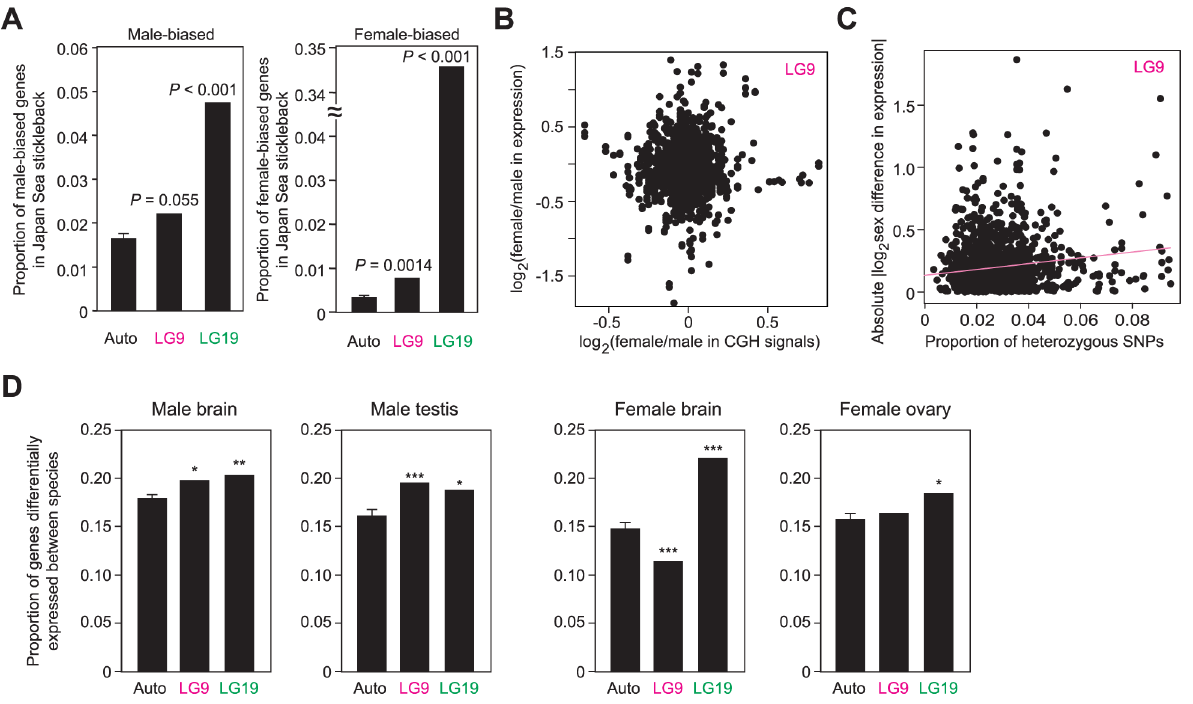
Figure 6. Contribution of neo-sex chromosomes to the evolution of sex and species differences in gene expression. (A) Proportion of male-biased and female-biased genes for autosomes, LG9, and LG19. (B) No significant correlation between sex differences in CGH signals and sex differences in expression levels. (C) Significant correlation between the proportion of heterozygous SNPs in the 10-kb upstream of genes and sex differences in expression levels. (D) Proportion of genes differentially expressed between species for each sex. A Grubbs’ outlier test was conducted to investigate whether LG9 and LG19 are outliers of all other linkage groups: *, P , 0.05; **, P , 0.01; ***, P , 0.001. For autosomes, means 6 S.E. are